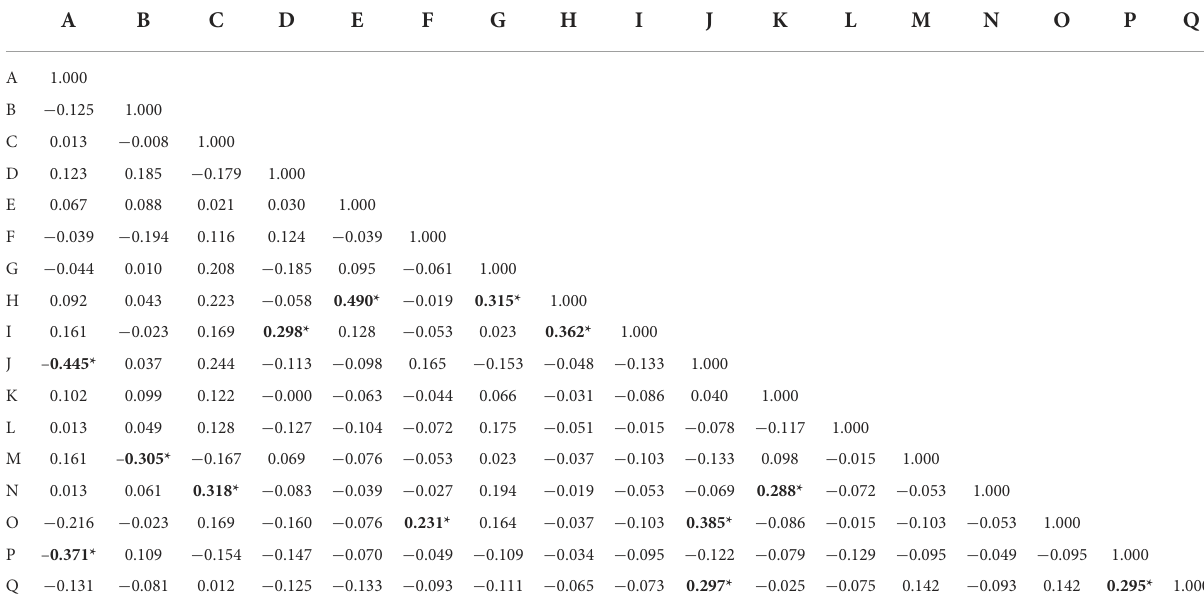
TABLE 4 Symptoms and clinical signs as predictors of respiratory diseases in camels.